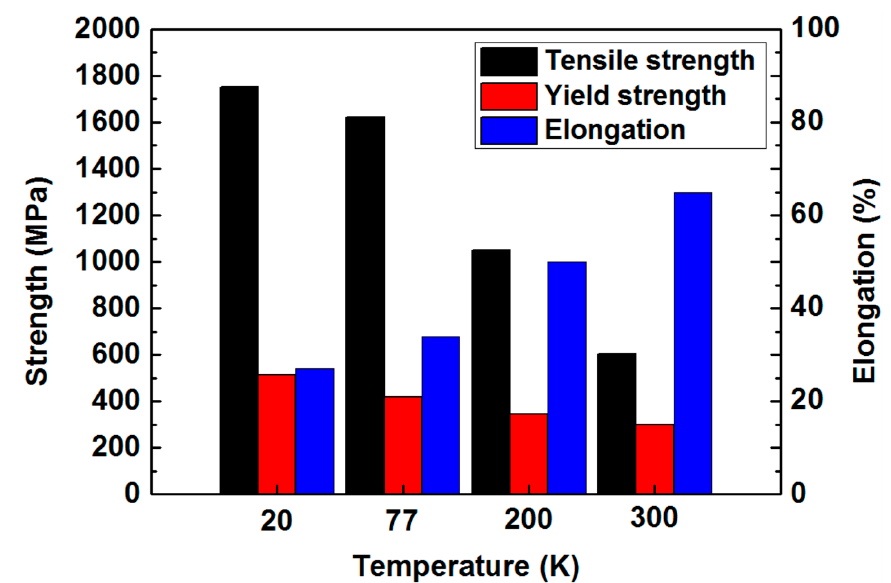
Figure 1. Cryogenic properties of 18Cr–8Ni stainless steel at different temperatures.